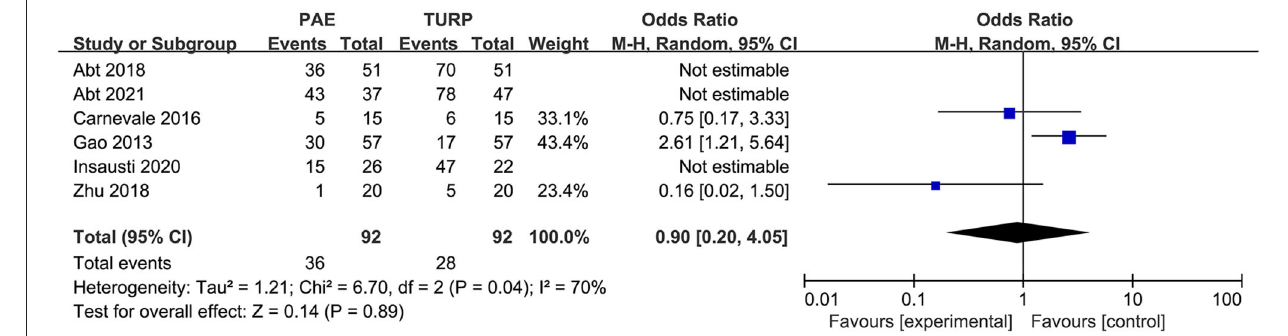
FIGURE 8 | Forest plot for complications.